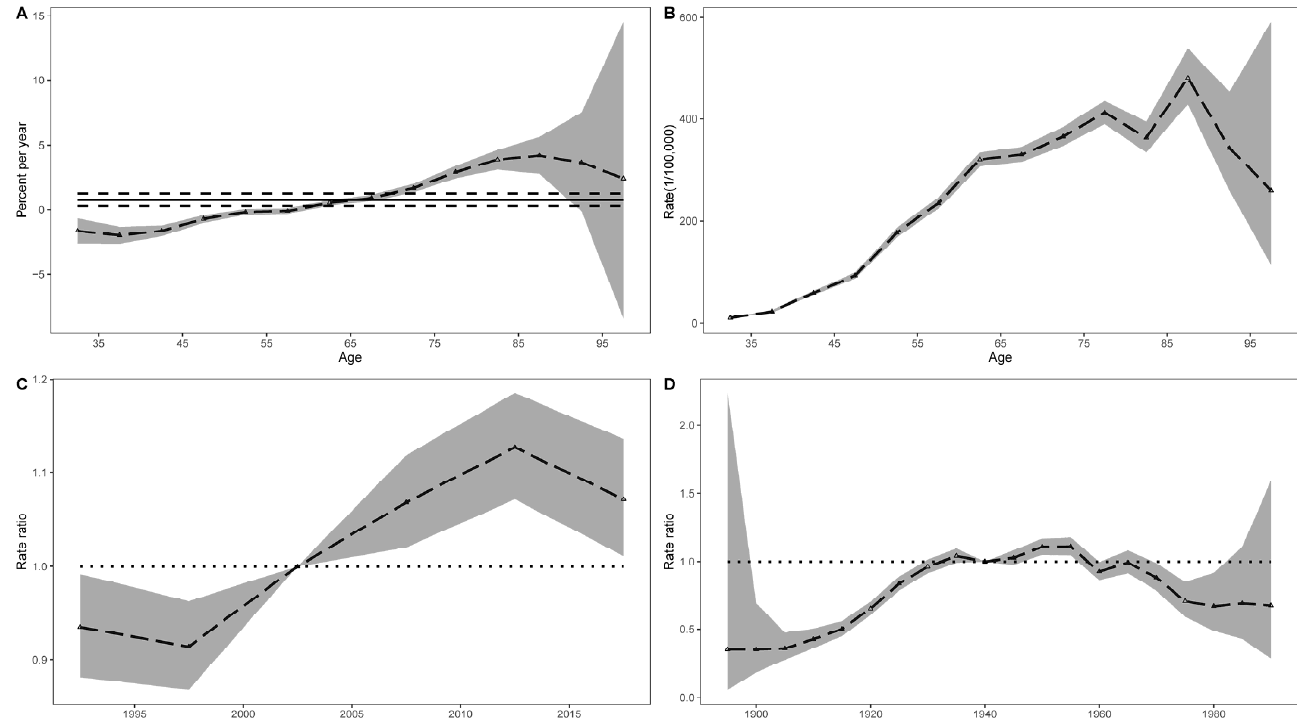
Figure 3. Effects of age, time period, and cohort on lung cancer DALYs attributable to occupational carcinogens from 1990 to 2019 in China. ( A ) Local drifts with net drift values, the horizontal solid and dashed lines represent the net drift and its 95% CI respectively, the dashed line and shaded area represent the local drifts and their 95% CIs. ( B ) Fitted longitudinal age curves of DALYs rate of lung cancer, the dashed line and shaded area represent age-specific rate of lung cancer DALYs due to occupational carcinogens and their 95% CIs, respectively. ( C ) Relative risks of each period compared with the reference period (2000–2004) adjusted for age and cohort effects (dashed line with triangle) and the corresponding 95% CIs (shaded area). ( D ) Relative risks of each cohort compared with the reference cohort (cohort 1940–1944) (dashed line with triangle), adjusted for age and time period effects and the corresponding 95% CIs (shaded area).